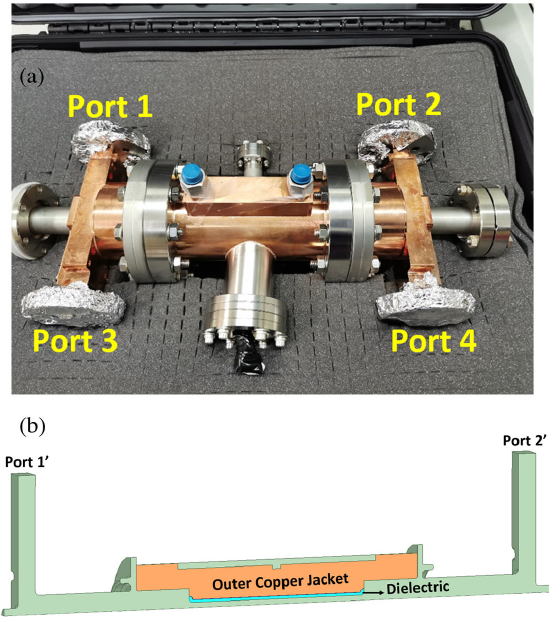
FIG. 18. The mechanical assembly (a) and simulation modeling (b) of two end-part prototypes and center-part prototype (see second row of Table